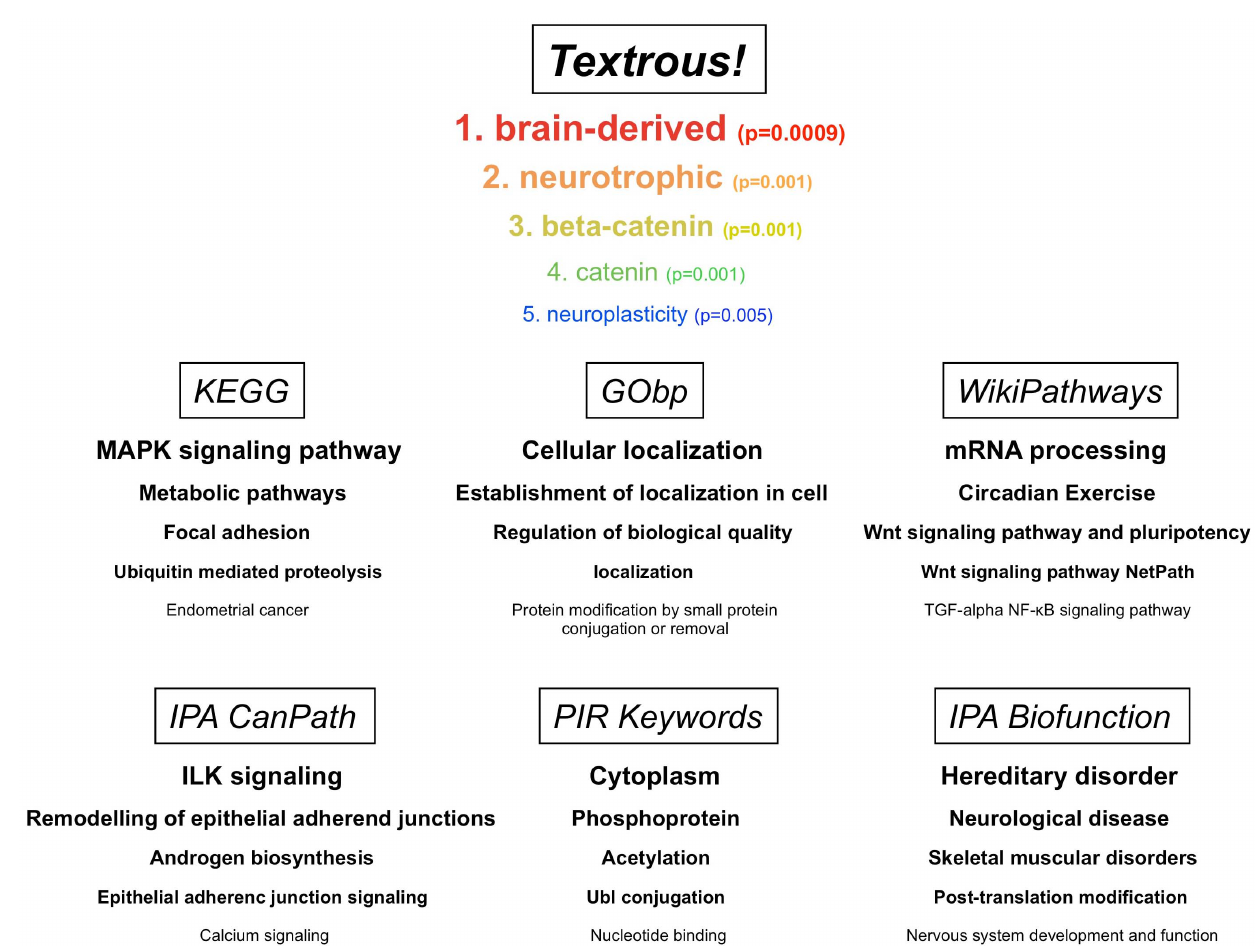
Figure 5. Multiple comparison of the functional accuracy and specificity of Textrous! -extracted data with other data analysis modules. The top five most significantly associated words obtained from Textrous! collective analysis of the mouse learning dataset are compared to the top 5 most significantly enriched, KEGG pathways, GO-biological processes (GO bp ), WikiPathways, Ingenuity Pathway Analysis (IPA) Canonical Signaling Pathways (IPA CanPath), Protein Information Resource Keywords (PIR Keywords) and IPA BioFunctions generated using WebGestalt (KEGG, GObp, WikiPathways), IPA (CanPath, BioFunctions) and NIH-DAVID (PIR Keywords) respectively. The text size and descending sequential orientation indicate the first to the fifth most significantly enriched group for each analytical mode illustrated.